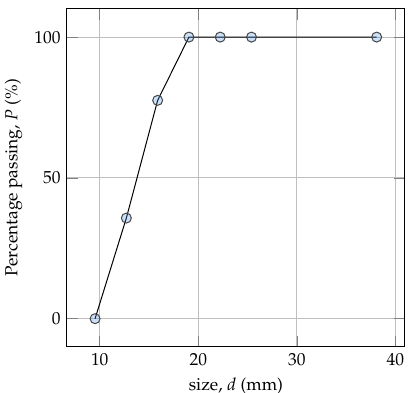
Figure 9. Particle size distribution of the quartz sample used in